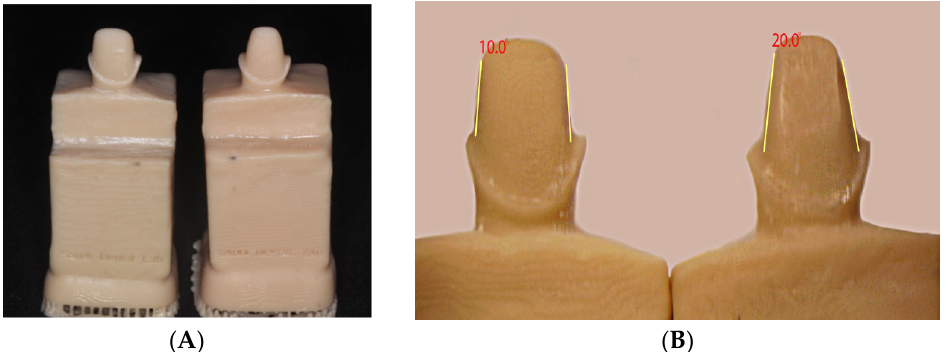
Figure 2. ( A ) Working models made with 3D-printed resin dies and 10° and 20° tapers. ( B ) Tapers measured using a computer system consisting of a stereomicroscope with a connected USB CCD camera, a personal computer, and compatible measurement software.